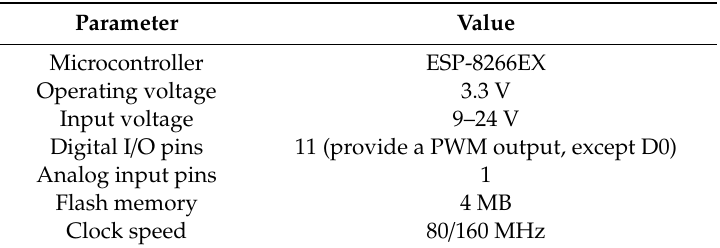
Table 1. Arduino D1R1 characteristics [34].